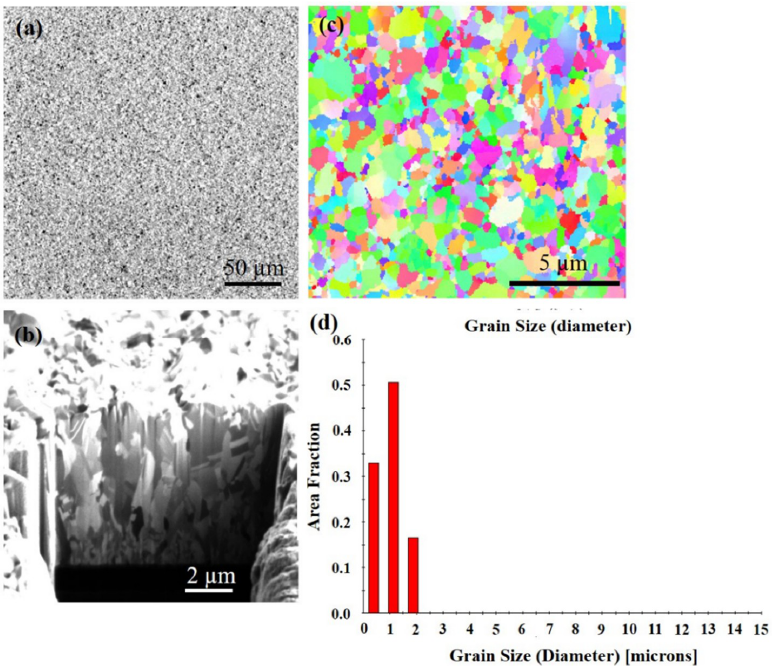
Figure 9. FIB micrographs of randomly oriented Cu. ( a ) Top surface. ( b ) Cross section. ( c ) Plan-view of the inverse pole figure map from EBSD of the sample at initial state. ( d ) Grain size distribution of the grains in pole Figure 9c.